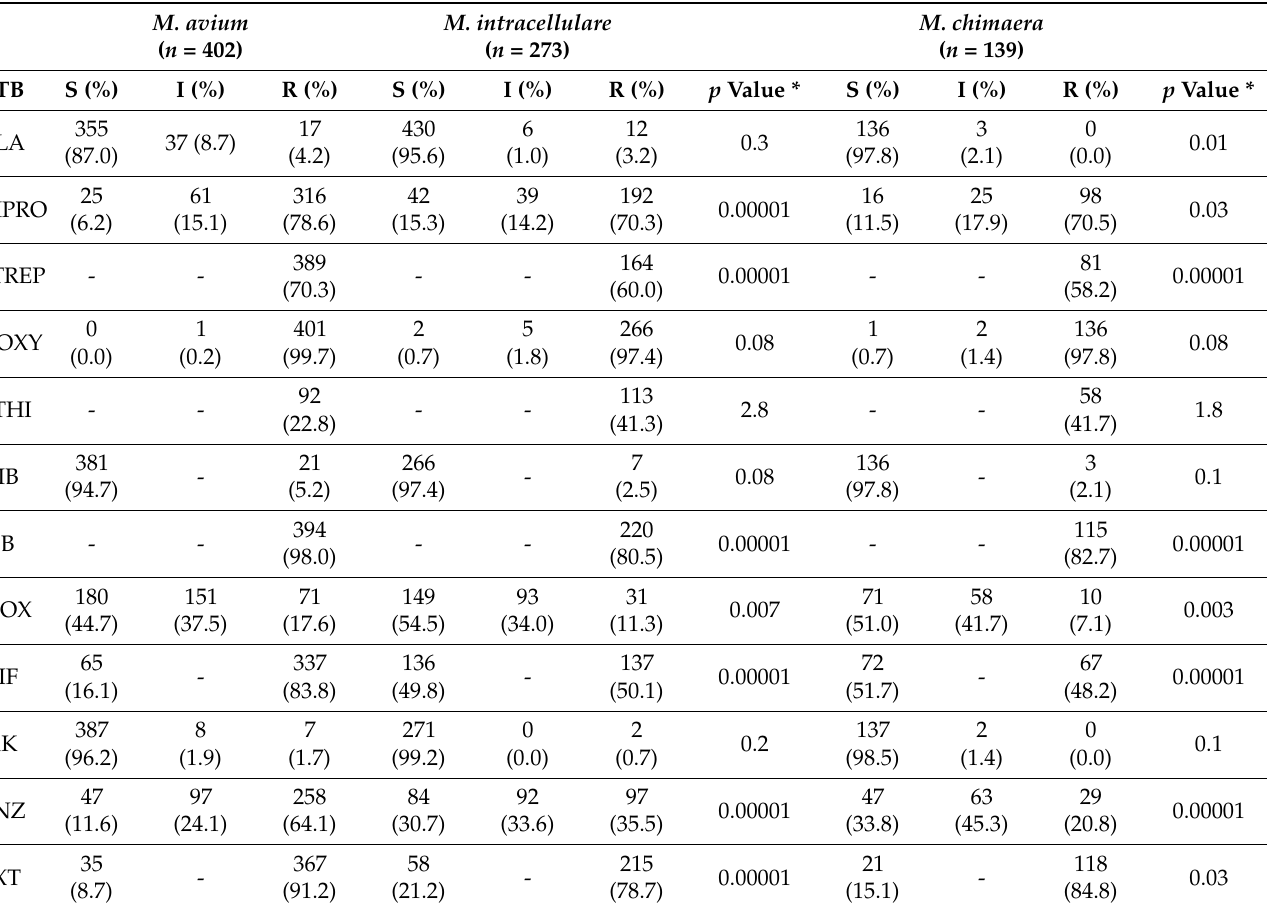
Table 1. Distribution of the susceptibility testing results of 402 M. avium , 273 M. intracellulare , and 139 M. chimaera isolates versus 12 antibiotics.